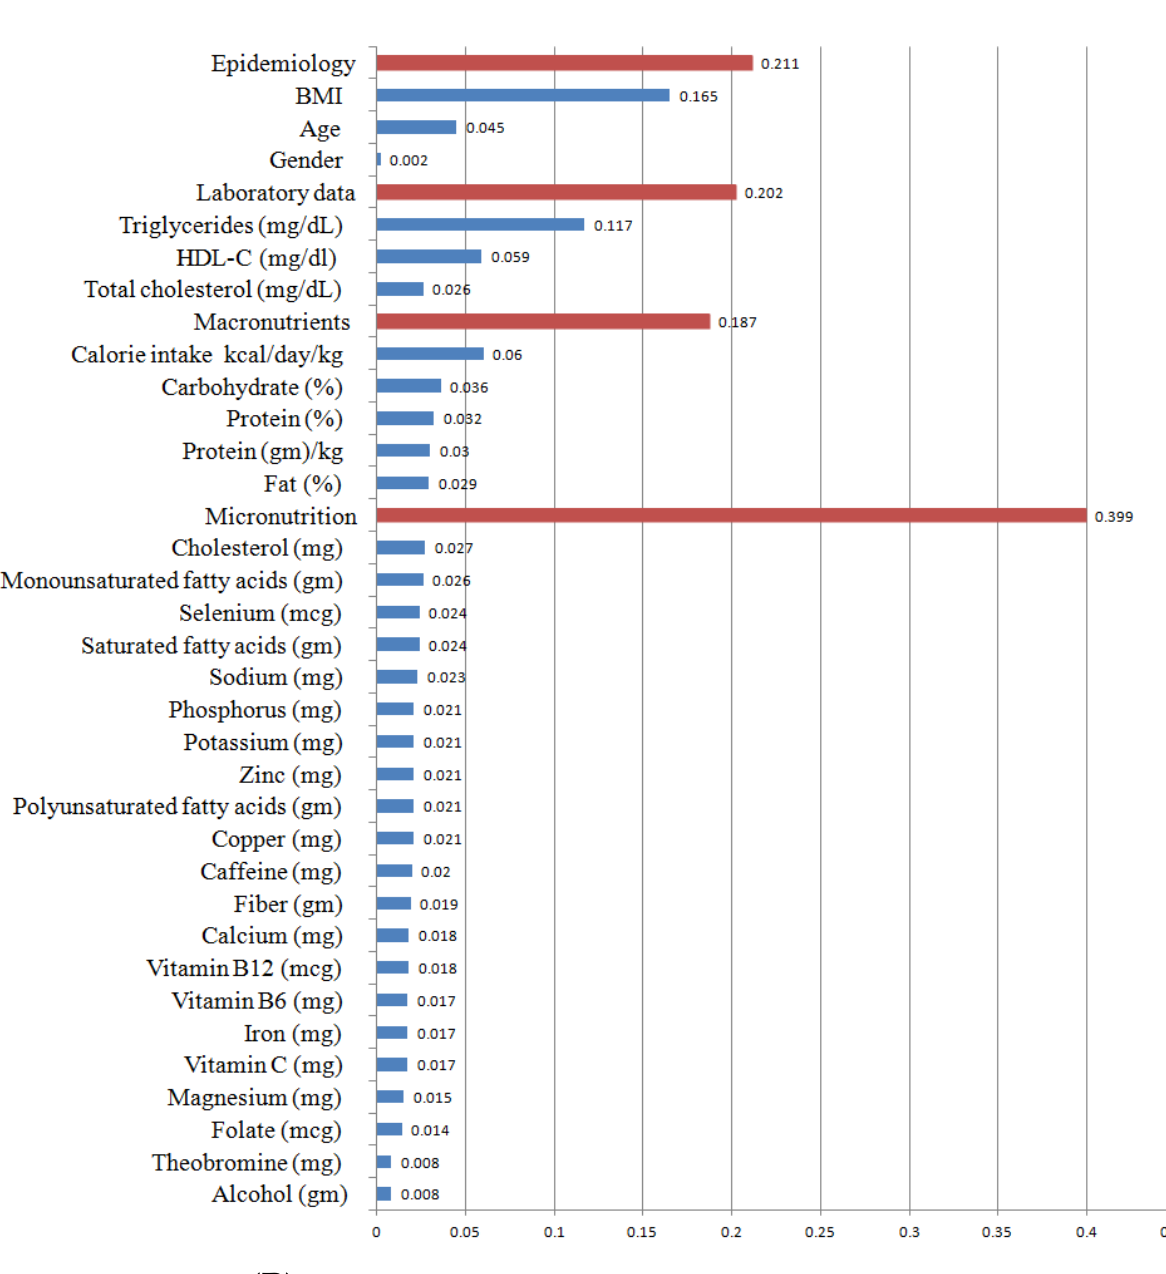
Figure 3. Feature importance. ( A ) XGboost algorithm. ( B ) RF algorithm. In the XGBoost algorithm ( A ), BMI had a large impact on IR (0.1262), followed by triglyceride (0.0754), protein intake ratio (0.0537), age (0.0487), blood total cholesterol value (0.0433), daily cholesterol intake (0.0430), daily calorie intake (0.0429), blood HDL value (0.0424), daily zinc intake (0.0420), and daily saturated fatty acid intake (0.0414). In the RF algorithm ( B ), similarly, BMI had a large impact on IR (0.1654), followed by triglyceride (0.0117), daily calorie intake (0.0602), blood HDL value (0.0587), and age (0.0446). (The dark red line indicated group name and the blue line indicated individual item name)